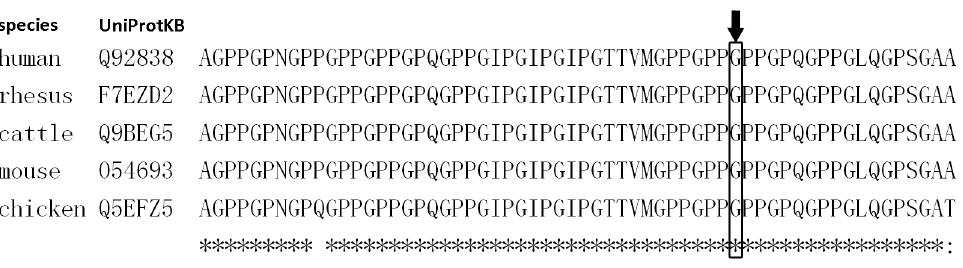
Figure 3. Domains of Ectodysplasin A and mutation distribution. Mutations in red are those identified in this study. Mutations in black are those identified in our previous study [5]. Collagen: collagen ‐ like domain; Furin: furin sites; TNF: tumor necrosis factor domain.